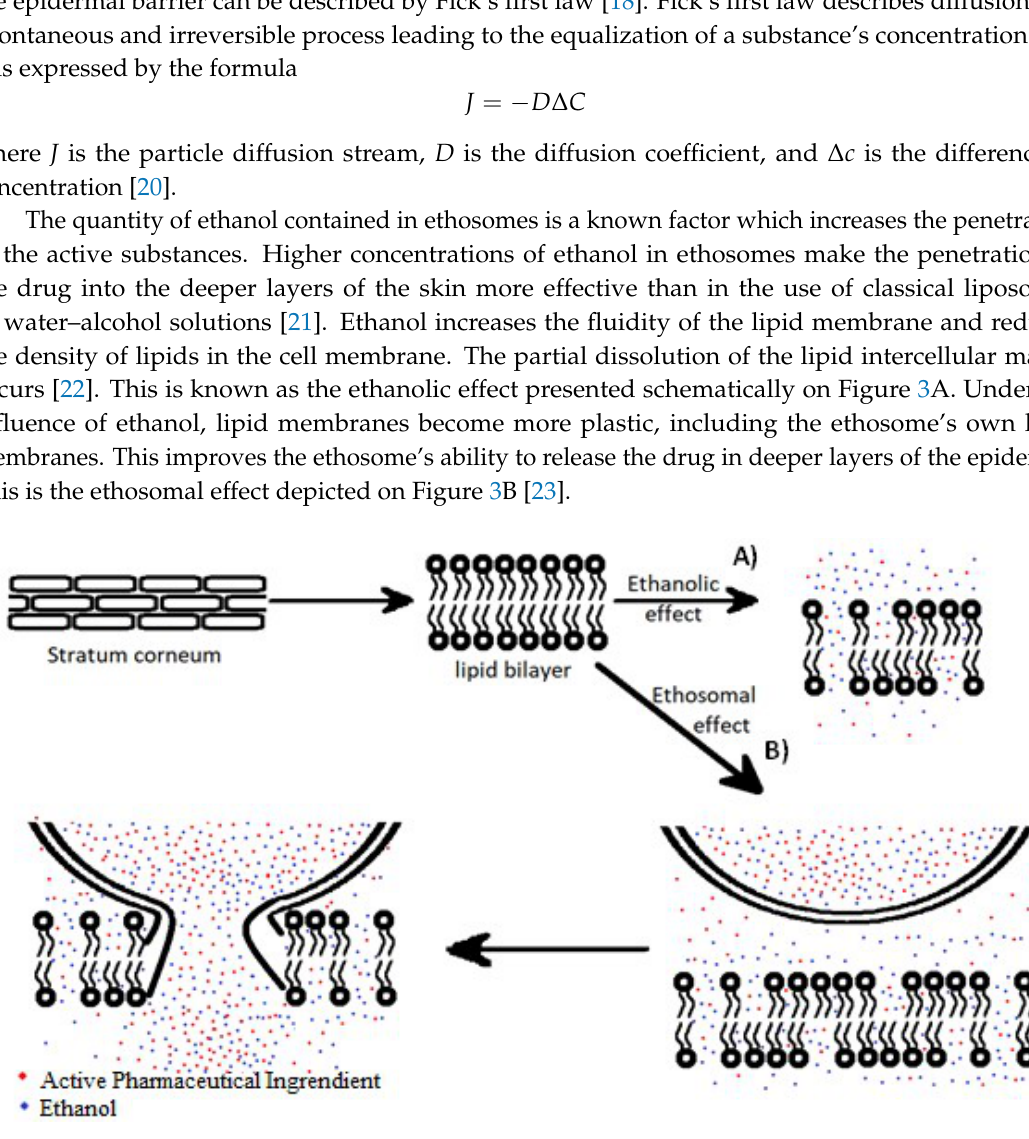
Figure 3. ( A ) The ethanolic and ( B ) ethosomal effects of ethosomes.